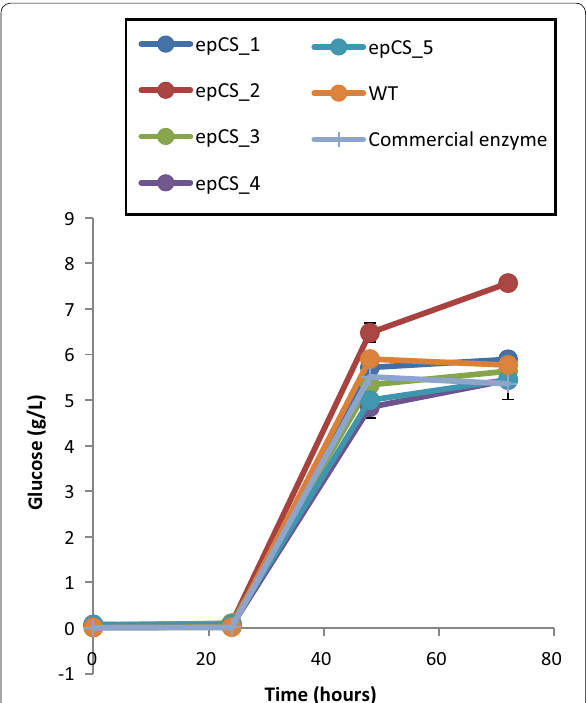
Fig. 4 Enzymatic hydrolysis of pretreated A. donax biomass. Hydroly- sis reactions were performed in Na acetate pH6 and 50 °C using cock- tails prepare with commercial enzymes (xylanase and β-glucosidase), in combination with CelStrep WT and epCS